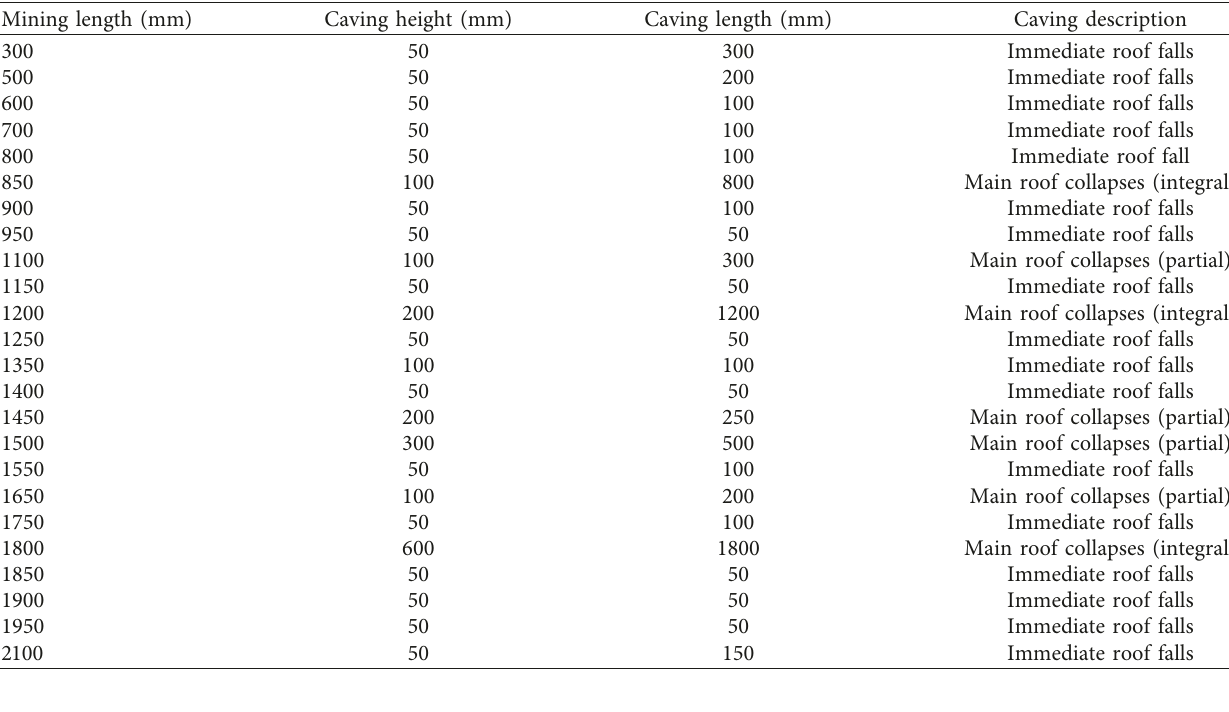
Table 5: Description of the mining process (mining face 5-3).